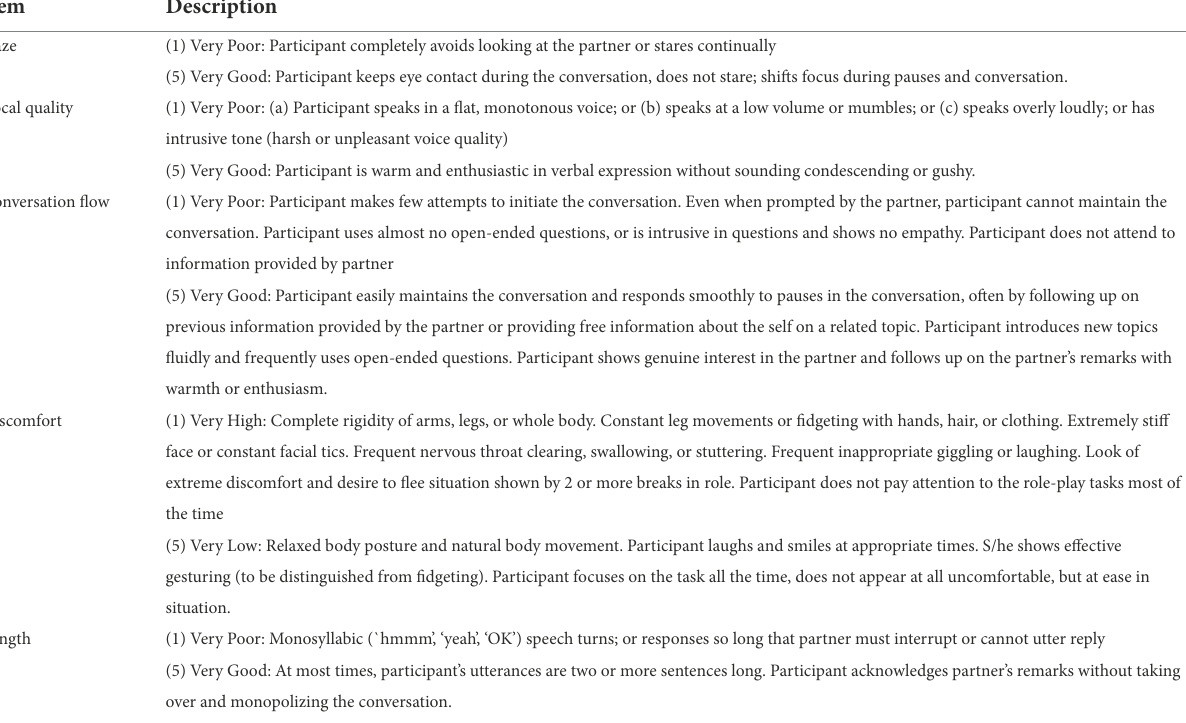
TABLE 4 Social Performance Rating Scale, (Fydrich and Chambless,